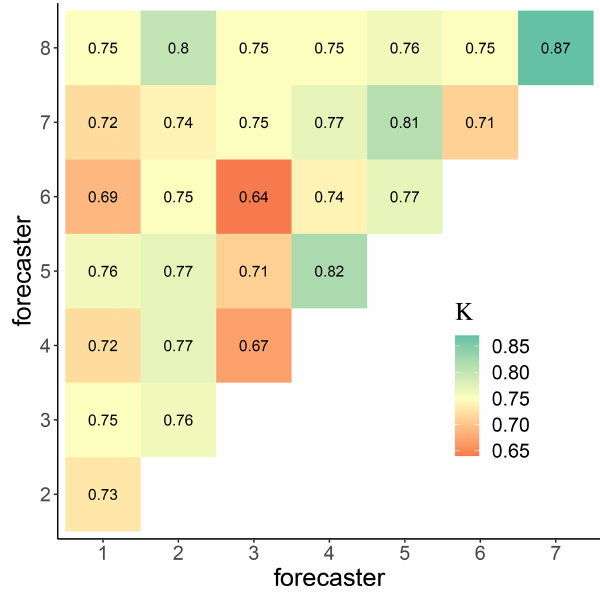
Figure A1. Kappa scores for the eight forecasters (f1–f8); κ > 0 . 6 is considered substantial , κ > 0 . 8 almost perfect (Landis and Koch, 1977).